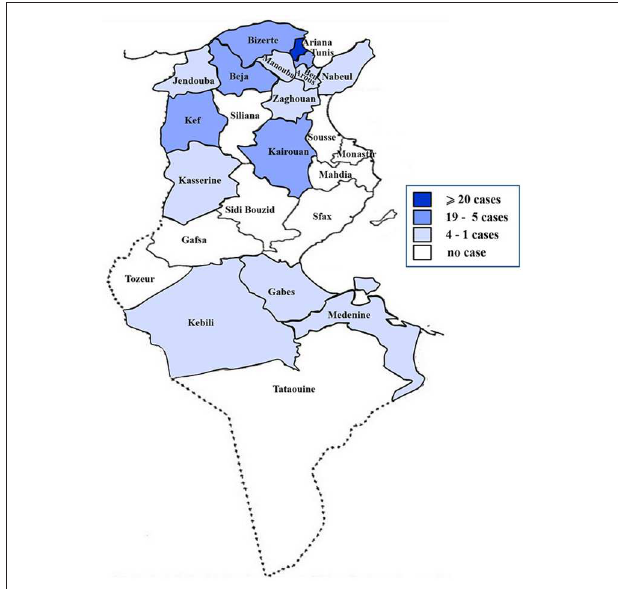
FIGURE 1 | Map of Tunisia showing origin of analyzed samples during 2014–2017.